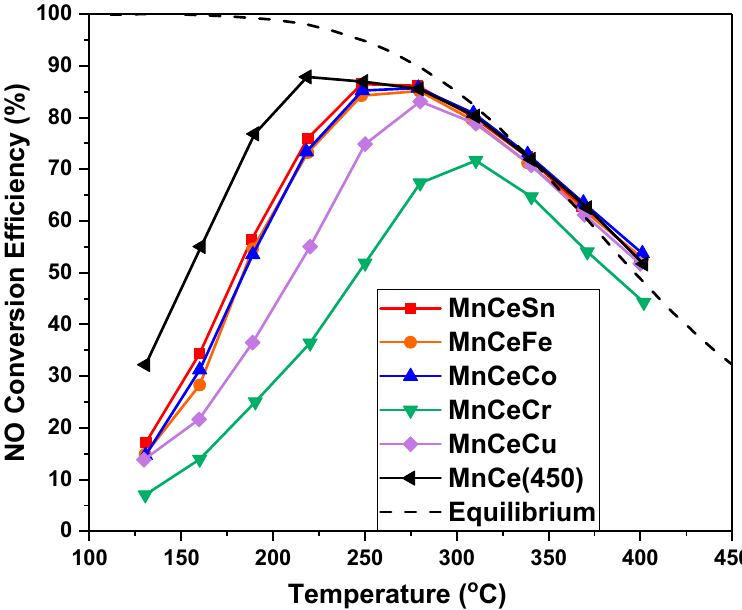
Figure 5. NO conversion over MnO x -CeO 2 with metal doping.